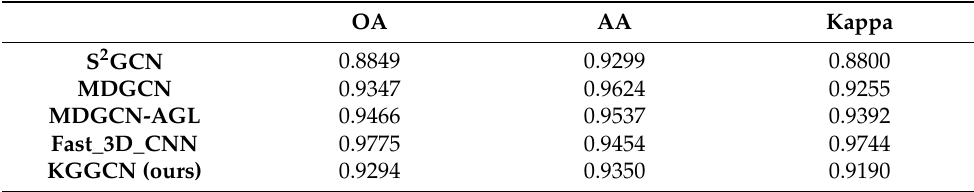
Table 9. The comparison of models in Indian Pines dataset.